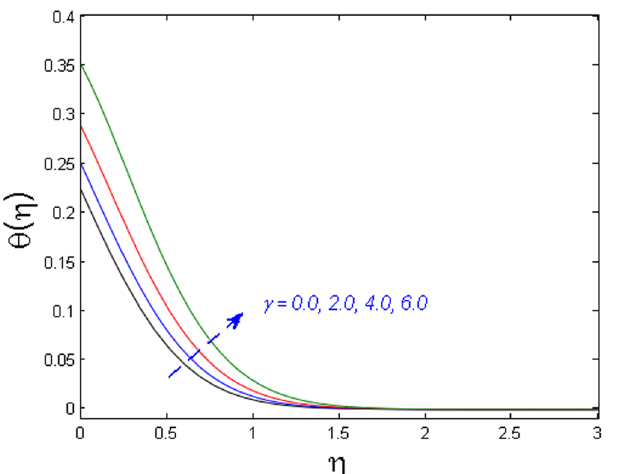
Figure 17. Effect of γ on θ ( η